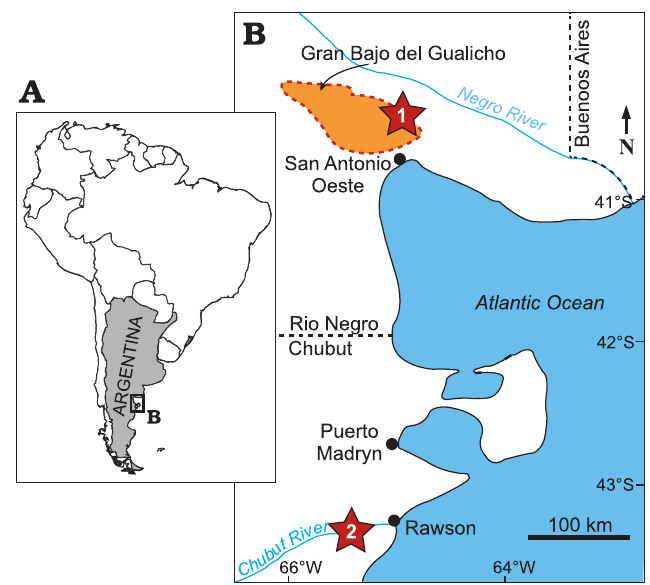
Fig. 1. Geographic location of studied area in Patagonia, southern Argen- tina ( A ) and location of the marine Miocene outcrops ( B , stars) where the specimens included in this study were collected: Gran Bajo del Gualicho Formation (1) and Gaiman Formation